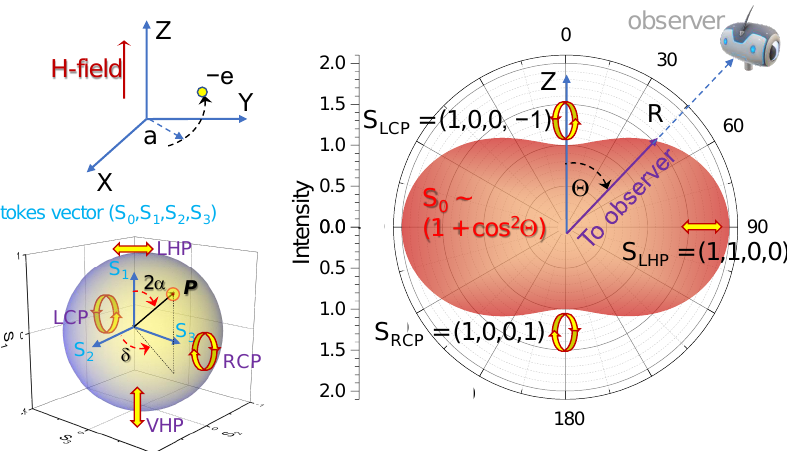
Figure A5. An electron spinning around magnetic H-field at radius a emits radiation which depen- dent on the position of observer at R distance will be dependent on the viewer angle θ . Intensity profile has peanut shape defined by Stokes parameter S 0 ∝ ( 1 + cos 2 θ ) . Stokes vecotors for θ = 0, π corresponds to left and right circular polarisation LCP and RCP, respectively, while for θ = π /2 it is linear horizontally polarised (LHP); corresponds to the slit orientation of the 1th-mirror. A point P on the Poincare sphere ( S 2 , S 2 , S 3 ) with radius S 0 defines an arbitrary state of polarisation. The angles 2 α and δ are the spherical coordinates